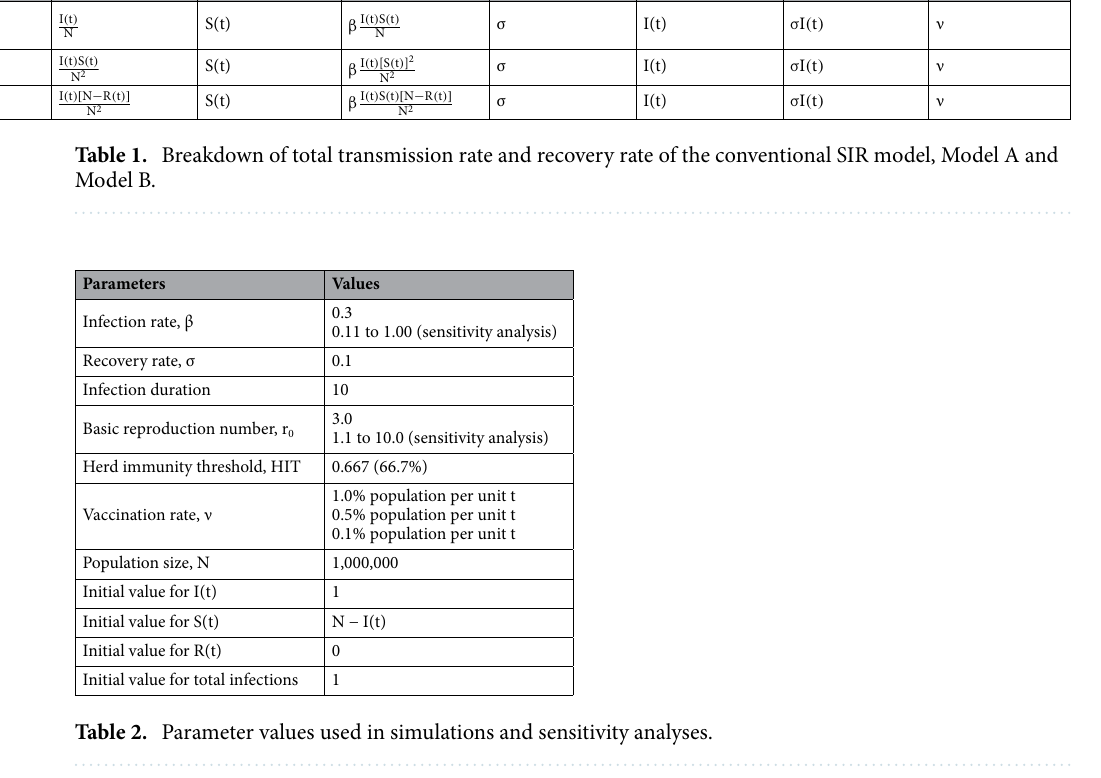
Fig. 3. The total immunized population would consist of those who had developed natural immunity and vaccine immunity. At high vaccination rates, the total immunized population was largely contributed by those acquiring vaccine immunity. At low vaccination rates, the total immunized population was largely contributed by those acquiring natural immunity. We simulated all vaccine models at three vaccination rates, as stated in Table 2. At each vaccination rate, we evaluated the size of each compartment at the time when the HIT was reached, and at the end of simulations (t = 500 for ν = 1.0%, t = 300 for ν = 0.5%, and t = 200 for ν = 0.1%). The vaccination rate was set to zero after the HIT was reached until the end of simulations. In sensitivity analyses, we evaluated total infec- tions generated by all three models at the end of simulation across r 0 values from 1.1 to 10.0 without vaccination. In an effort to validate the new model, the conventional SIR model, Model A and Model B were used to simulate the transmission dynamics of seasonal influenza in the United States. The disease burden of symp- tomatic illness as projected by the models at equilibrium state were compared with estimates reported by the Centers for Disease Control and Prevention (CDC) from 2010 to 2019 24 . We assumed complete immunity was acquired after recovery. Subsequently, we applied a basic reproduction number (r 0 ) of 1.3 for seasonal influenza 25 ,